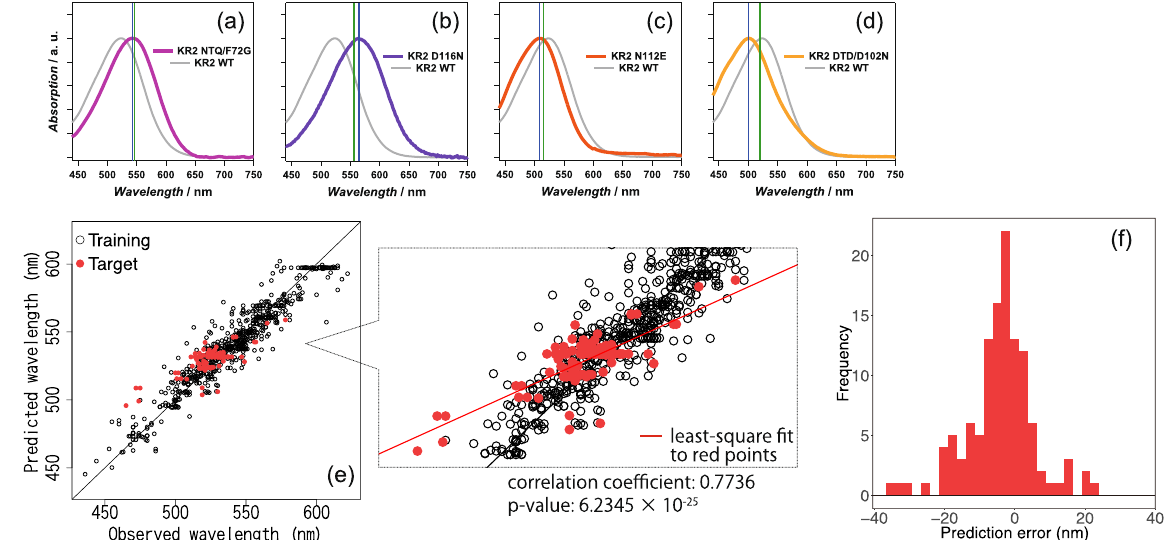
Figure 6. Absorption wavelength prediction results for KR2 wildtype and its 118 variants. ( a – d ) Absorption spectra of KR2 mutants (( a ) KR2 NTQ/F72G, ( b ) D116N, ( c ) N112E, and ( d ) DTD/D102N) with their absorption maxima as predicted by ML analysis (green lines) and experimentally determined (blue lines). The spectrum of KR2 wildtype is indicated by the solid grey line. ( e ) The horizontal axis represents the experimentally observed absorption wavelengths, whereas the vertical axis represents the absorption wavelengths predicted by the ML model. The red points indicate the KR2 group rhodopsin proteins in the target set, whereas the black points indicate other rhodopsin proteins in the training set. ( f ) Histogram of the prediction errors for KR2 group proteins in the target